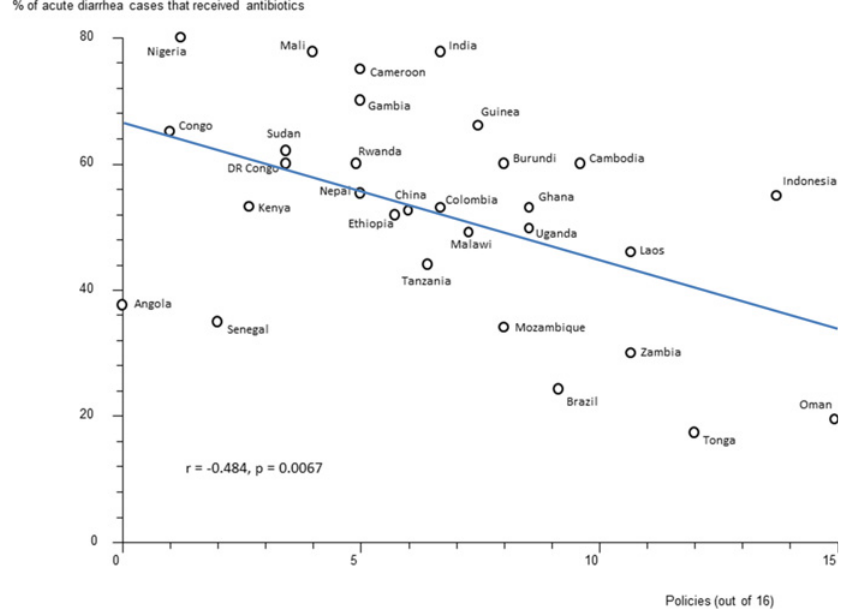
Fig 1. Correlation between the number of implemented policies (out of 16) and the treatment of acute diarrhea with antibiotics. Correlation coefficient (r) = -0.484, p = 0.0067. Each data point (circle) represents a